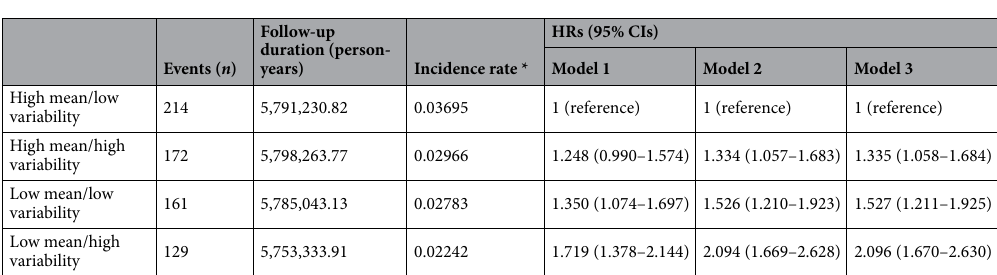
Table 2. Risk for Behçet’s disease according to HDL-C. Model 1: adjusted for age, sex, alcohol use, smoking, exercise, and income. Model 2: adjusted for model 1 plus body mass index, diabetes mellitus, and hypertension. Model 3: adjusted for model 2 plus mean HDL-C. The low mean group includes participants in the first quartile of mean HDL-C (men: < 44.7 mg/dL, women: < 51.7 mg/dL), the high mean group includes those in the second to fourth quartiles, the low variability group includes the first to third quartiles of HDL-C variability, and the high variability group includes the fourth quartile (men: ≥ 10.4%, women: ≥ 8.5%). CI confidence interval, HDL-C high-density lipoprotein cholesterol, HR hazard ratio, VIM variability independent of the mean. *Per 1000